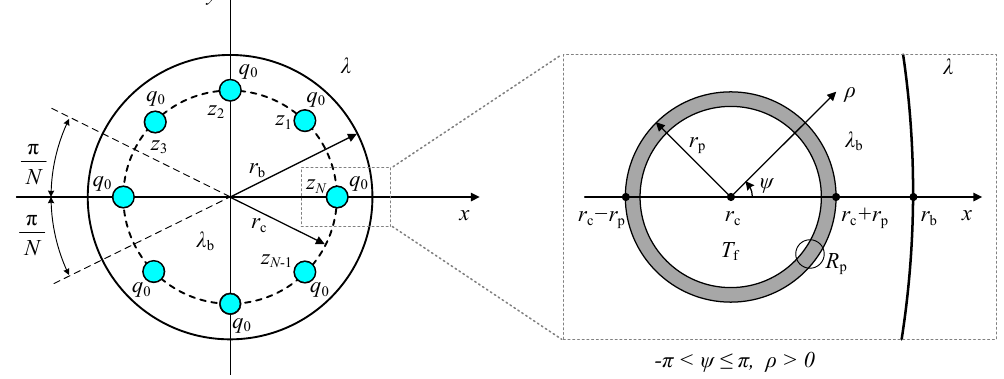
Figure 2. Energy pile with N (=8) heat exchanger pipes equally spaced on the circle r = r c . The heat injection from each pipe to the ground is q 0 (W/m). The value of q 0 is negative for heat extraction from the ground. The required fluid temperature T f for the heat carrier fluid to achieve the prescribed heat flux q 0 is to be calculated.